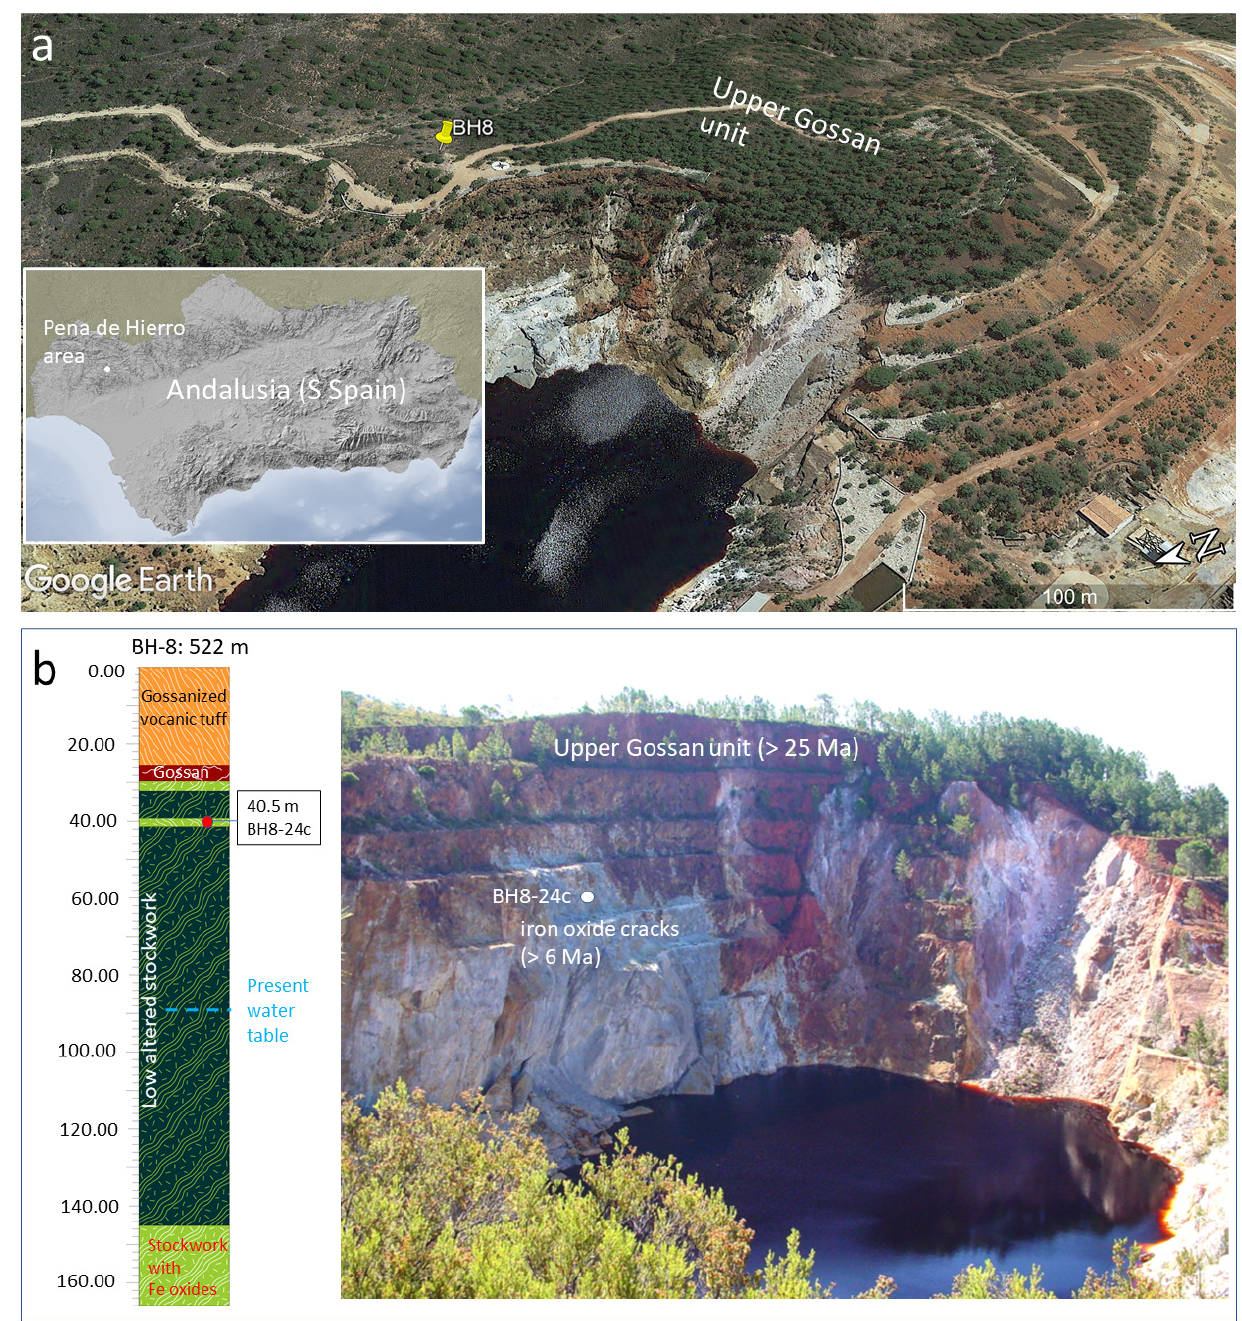
Figure 1. Composition of pictures and figures showing the geological features of the BH8 drilling site of Peña de Hierro. ( a ) Google Earth aerial image displaying the BH8 drilling location below the Upper Gossan (25 Ma) materials topping Peña de Hierro. ( b ) Geological section of the drilled geological units (gossanized volcanic tuff, gossan, stockwork with Fe oxides, and low altered stockwork) where sample BH8-24c was collected. The units can be partially recognized ( b ) at the material outcrops that are exposed in the pit lake of the abandoned mine, where different faults can be recognized affecting the gossan and the Carboniferous basement. The geological section and outcrop picture have been produced and owned by David Fernandez-Remolar.